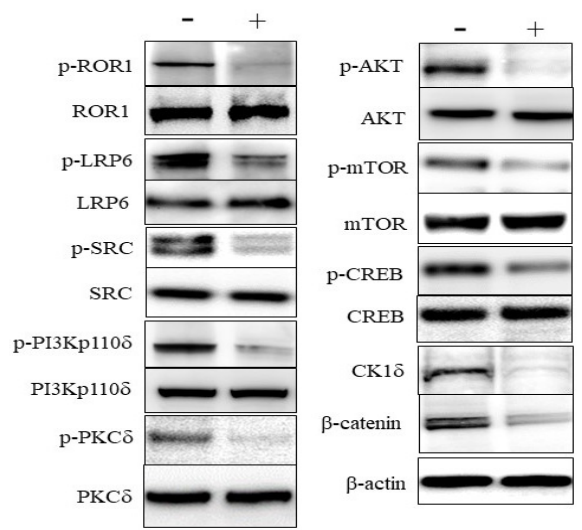
Figure 4. Effects of KAN0441571C (250 nM) (4 h) on ROR1 associated signaling molecules (Western blot) in the DLBCL cell line OCI-Ly3. ROR1, LRP6, SRC, PI3K δ , PKC, AKT, mTOR, and CREB